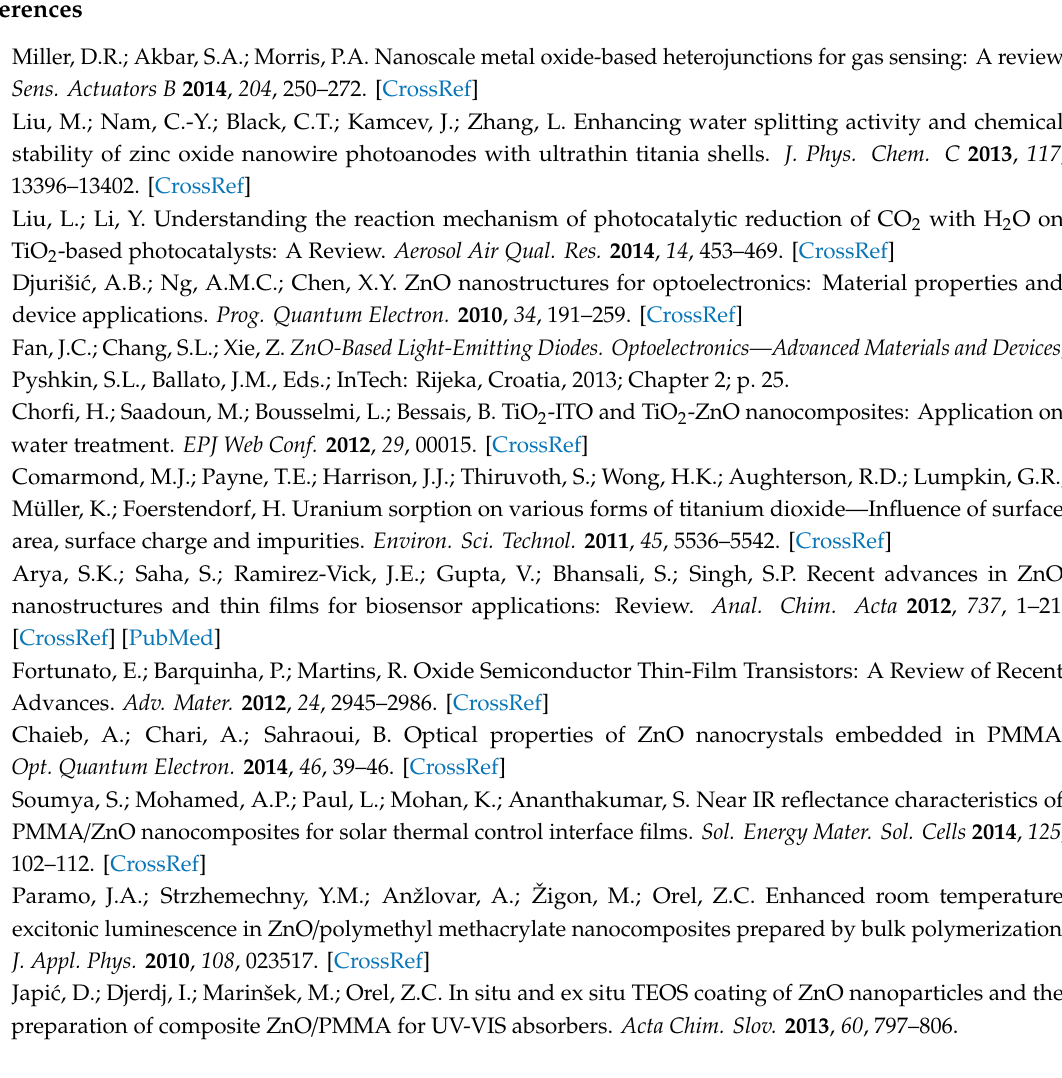
Figure S1: SEM images of the sensor layout, Figure S2: Multi-cycled UV response curve of the ‘S’ sample, Figure S3: Gas response plots to 1 ppm NO2 of S3 and S4